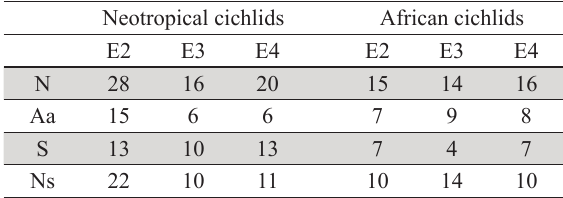
Number of variable sites in LWS gene of Neotropical and african cichlids. e2 = exon 2; e3 = exon 3; e4 = exon 4; N = nucleotide variable sites; aa = amino acidic variable sites; S = synonymous substitutions; nS = nonsynonymous